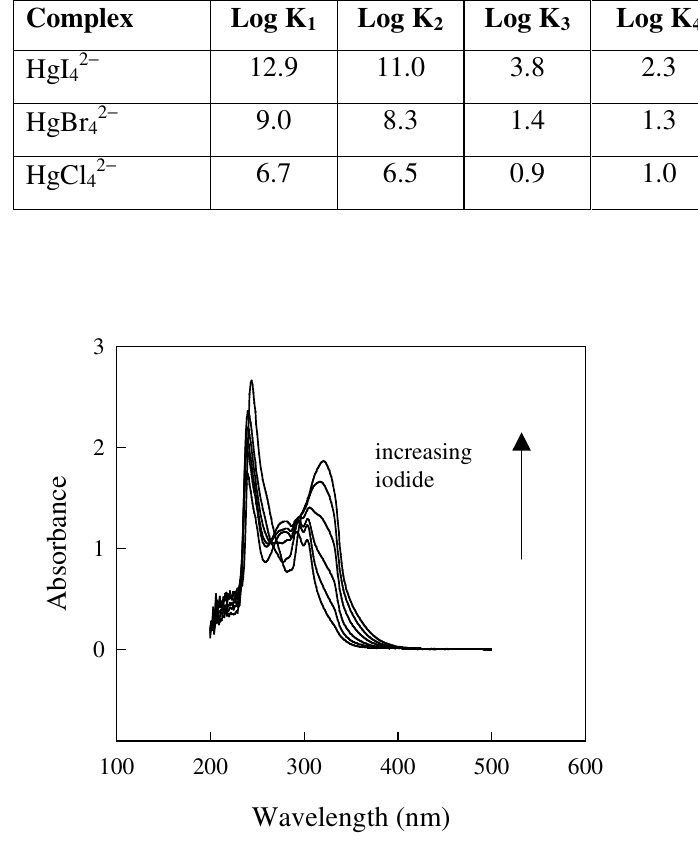
Figure 1. UV-Vis spectra of 5×10 - 5 M Hg(MBT) 2 complex after addition of several iodide mole ratios of 0.25, 0.5, 1, 2 and 4) in chloroform increments (I - /Hg(MBT) 2